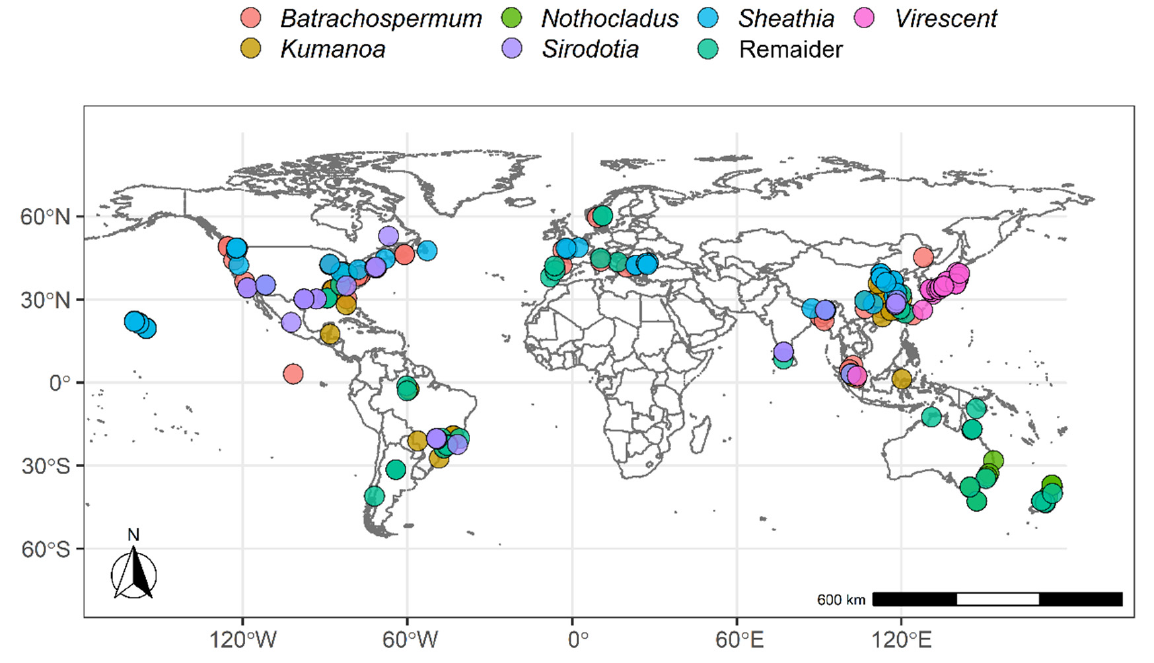
Figure 1. The global distribution of Batrachospermaceae.